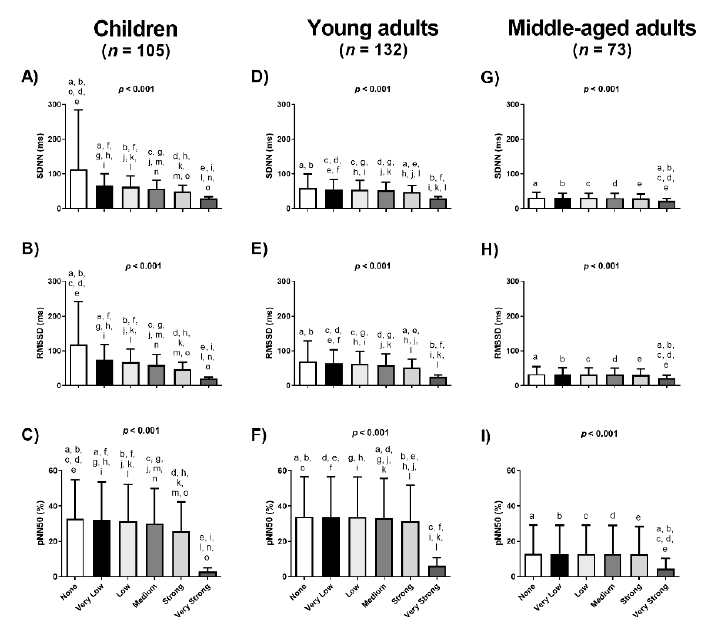
Figure 2. Di ff erences on the Heart Rate Variability (HRV) time-domain parameters using di ff erent Kubios filters in three di ff erent cohorts. Data are represented as mean and standard deviation. SDNN: standard deviation of all normal R–R intervals (Panels A, D and G ); RMSSD: squared root of the mean of the sum of the squares of successive normal R–R interval di ff erences (Panels B, E and H ); pNN50: number of pairs of adjacent normal R–R intervals di ff ering by more than 50ms in the entire recording (Panels C, F and I ); p value from the ANOVA comparisons; similar letters means Bonferroni post-hoc di ff erences.